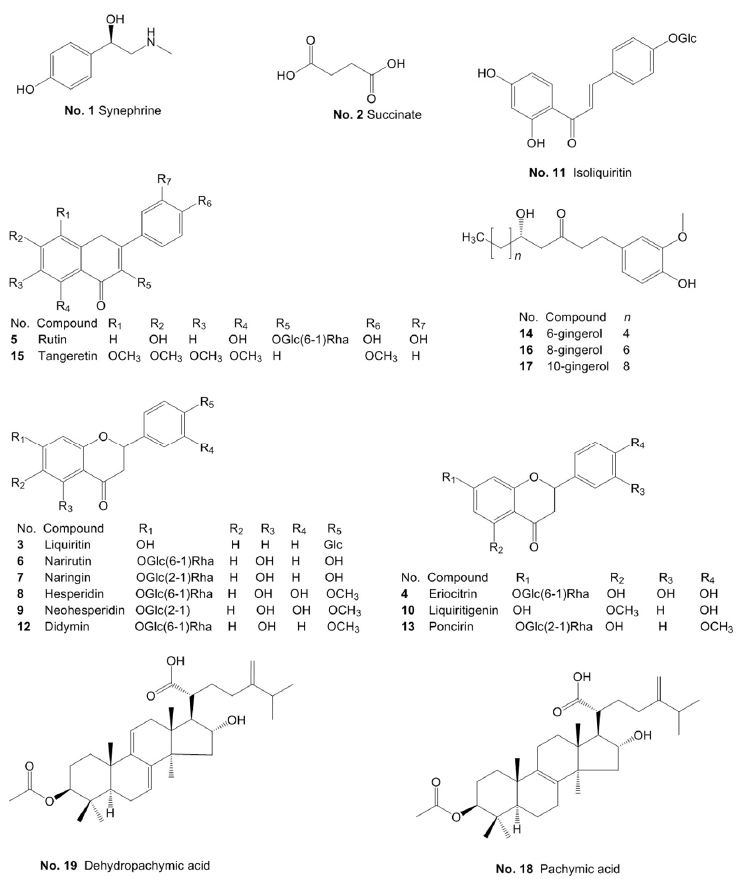
Figure 1. Structures of 19 chemicals analyzed in WDD.